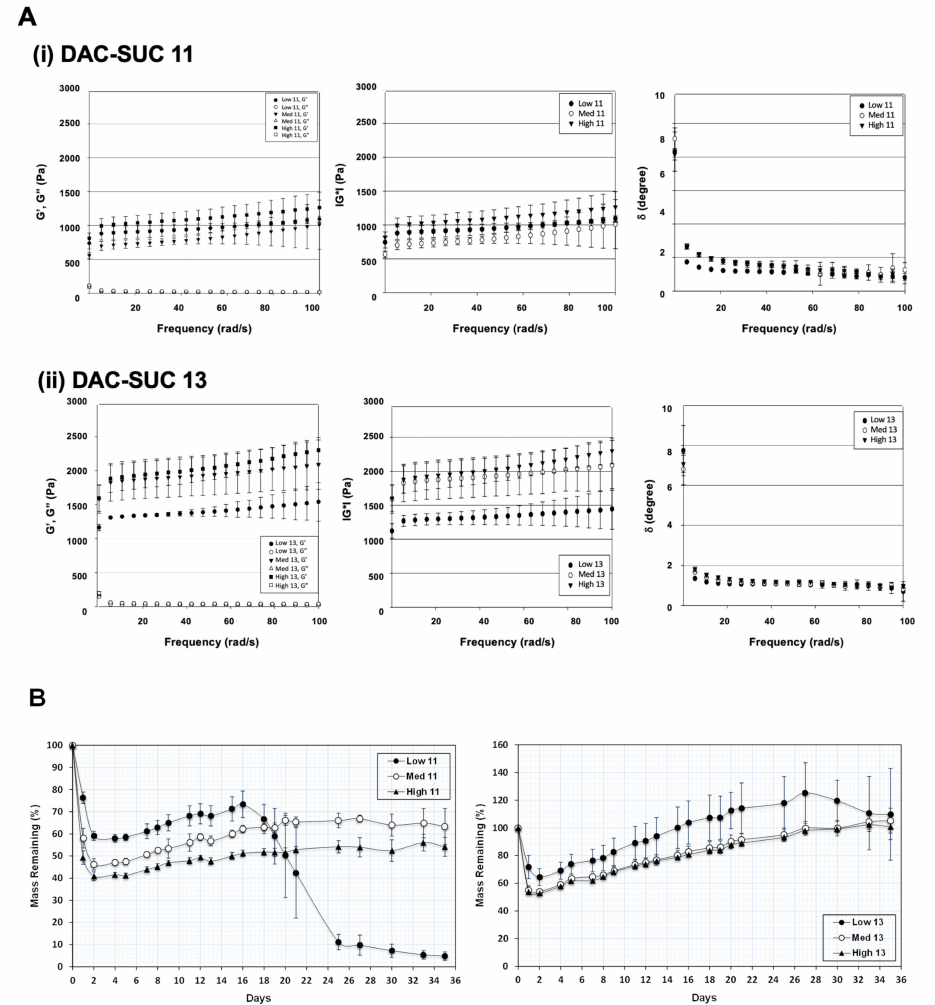
Figure 2. Rheological properties and mass remaining of the DAC-SUC hydrogel. ( A ) Rheological characterization of ( i ) DAC-SUC 11 and ( ii ) DAC-SUC 13 hydrogel (frequency sweep) shown as the storage modulus (G’), loss modulus (G”), complex modulus |G*| and tangent of the phase angle ( δ ). The storage modulus G (cid:48) was increased with oxidation rate of DAC increase. ( B ) Mass remaining of DAC-SUC hydrogels. The weight loss of hydrogel was recorded for 35 days and